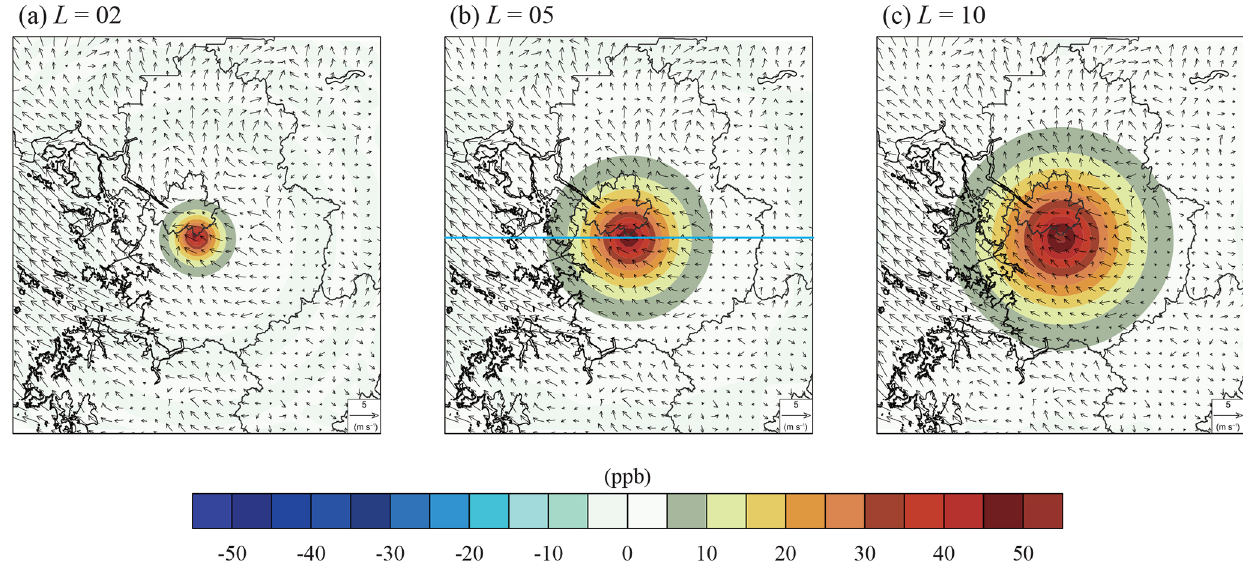
Figure 6. Horizontal distribution of analysis increments at surface resulted from the single observation experiment (EXP_A) with respect to radius of influence ( L ). Blue line in panel (b) stands for the location where the cross-sectional values of analysis increments are examined. Table 4. Statistics of the model results.